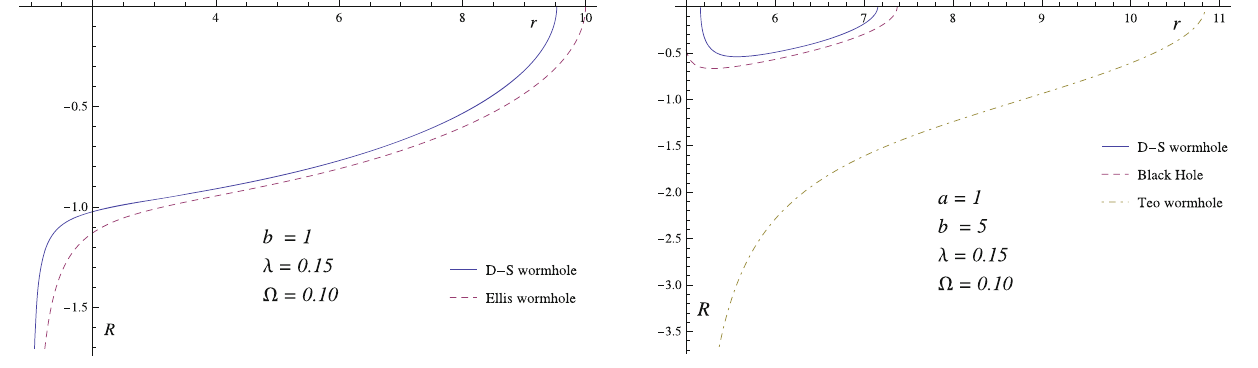
Fig. 3 Ratio between the calculated Casimir energy densities and the Minkowsky one in both Teo and rotating D–S wormhole spacetimes, as well as in the Kerr black hole, as a function of the radial coordinate, r > b